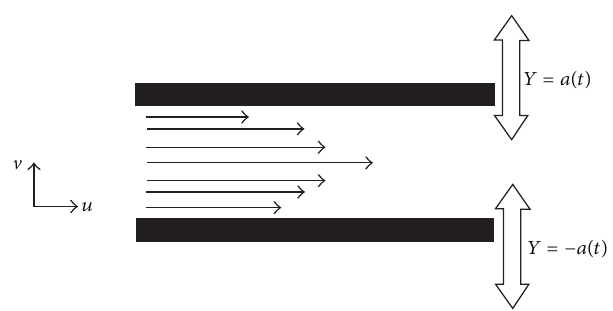
the plates. Take a Cartesian coordinate system (𝑥, 𝑦) where 𝑥 lies in the streamwise direction and 𝑦 is the distance measured in the transverse direction. Let 𝑢 and V be the velocity components in the directions of 𝑥 and 𝑦 increasing, respectively. It is assumed that the two plates are at 𝑦 = √(1 − 𝛼𝑡) , where 𝑎 𝑡 = 0 as shown ±𝑎 0 0 is the position at time in Figure